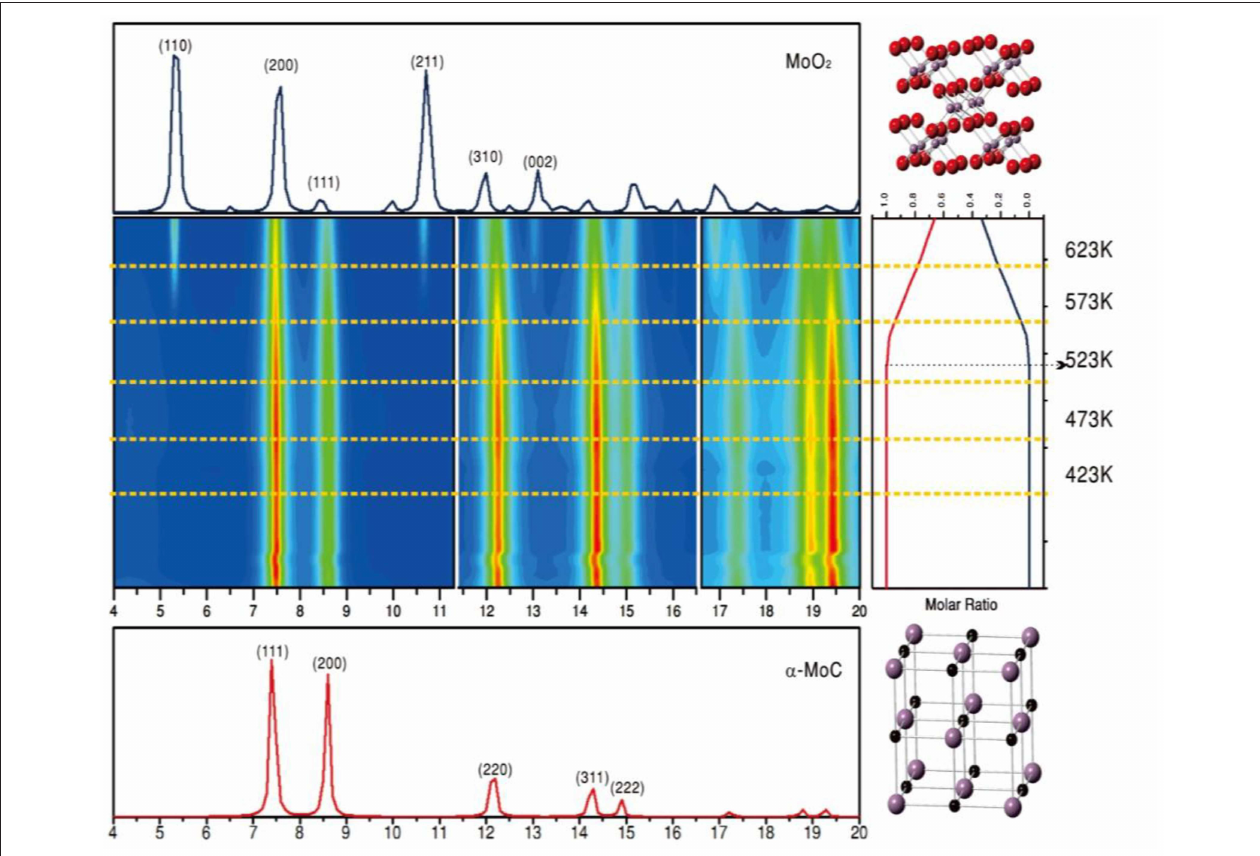
FIGURE 10 | In situ time-resolved X-ray diffraction patterns collected for a (2%)Au/ α -MoC powder catalyst at various temperatures under normal WGS reaction conditions (wavelength, 0.3196 Å). In the middle panel, the rainbow color scheme varies from no signal (blue) to very intense diffraction peaks (red). The crystal structures of α -MoC and MoO 2 are shown on the right side of the figure as ball-and-stick drawings (red, O; purple, Mo; black, C). Reproduced with permission from Yao et al. (2017), copyright 2017 by AAA